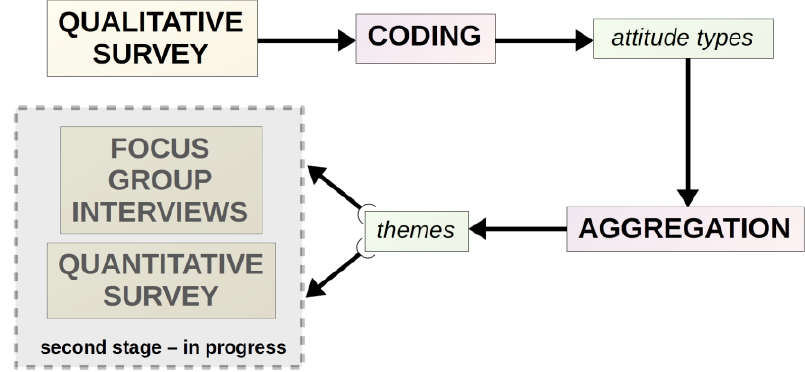
Figure 1. Research design for the project. Grayed out stages are in progress and are not described in this paper.